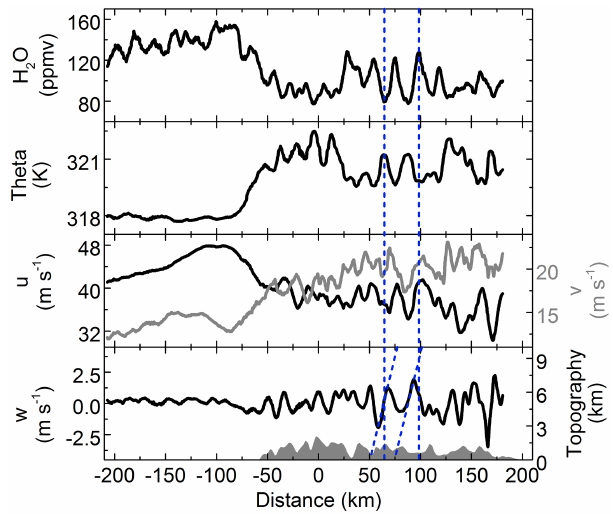
Figure 3. A portion of the time series of the DLR Falcon flight FF04 on 4 July 2014 shown in Fig. 2. The measurements were taken dur- ing the second flight leg at 8.9km altitude over the South Island of New Zealand. The distance refers to Mount Aspiring as the high- est summit during this mountain transect (west to east). The ver- tical blue dashed lines mark single wave events. The diagonal blue dashed lines in the bottom panel connect the maximum or minimum of the vertical wind motion with the respective maximum or mini- mum in the perturbations of water vapor and theta which displays the phase shift between these parameters.